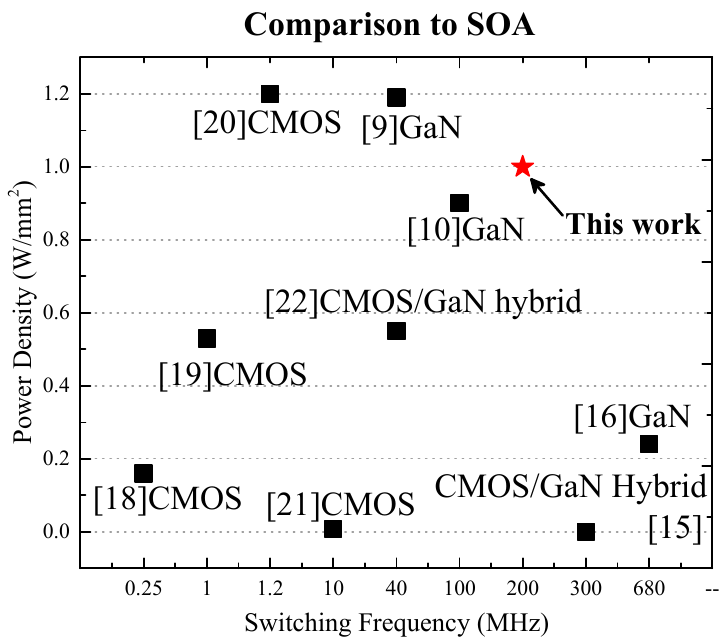
Figure 13. Comparison of this work to the state-of-the-art [9,10,15,16], [18–22] pulse signals at 200 MHz. Table 1. Performance comparison with previous DC-DC converters.